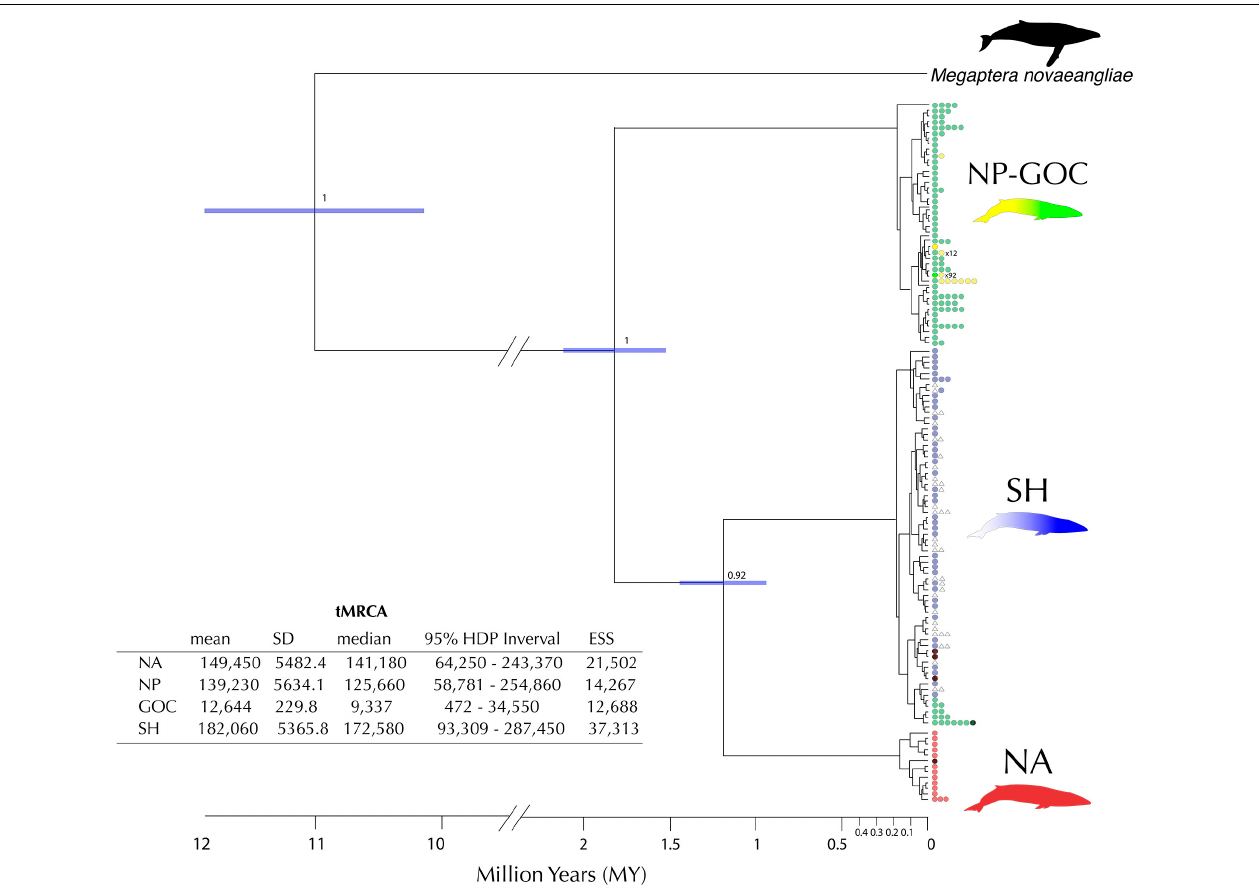
FIGURE 5 | Phylogenetic tree using extraspecific and intraspecific calibration points (as proposed by Ho et al., 2008). Node ages are the median values from both Bayesian molecular clock analyses and TMRCA of each clade estimated with a Bayesian Skyline plot. In each clade of interest (North Pacific NP, Southern Hemisphere SH and North Atlantic NA), nodes indicate the posterior probability support for the Bayesian Inference. The embedded table shows the time to Most Recent Common Ancestor (TMRCA) estimates for the different linages. Mean, standard deviation (SD), median, 95% Highest Posterior Density (HPD) and Estimated Sample Size (ESS) for Bayesian Inference are reported. Number of colored dots represents the frequency of that particular haplotype. The hatched haplotypes were retrieved from Cabrera et al.